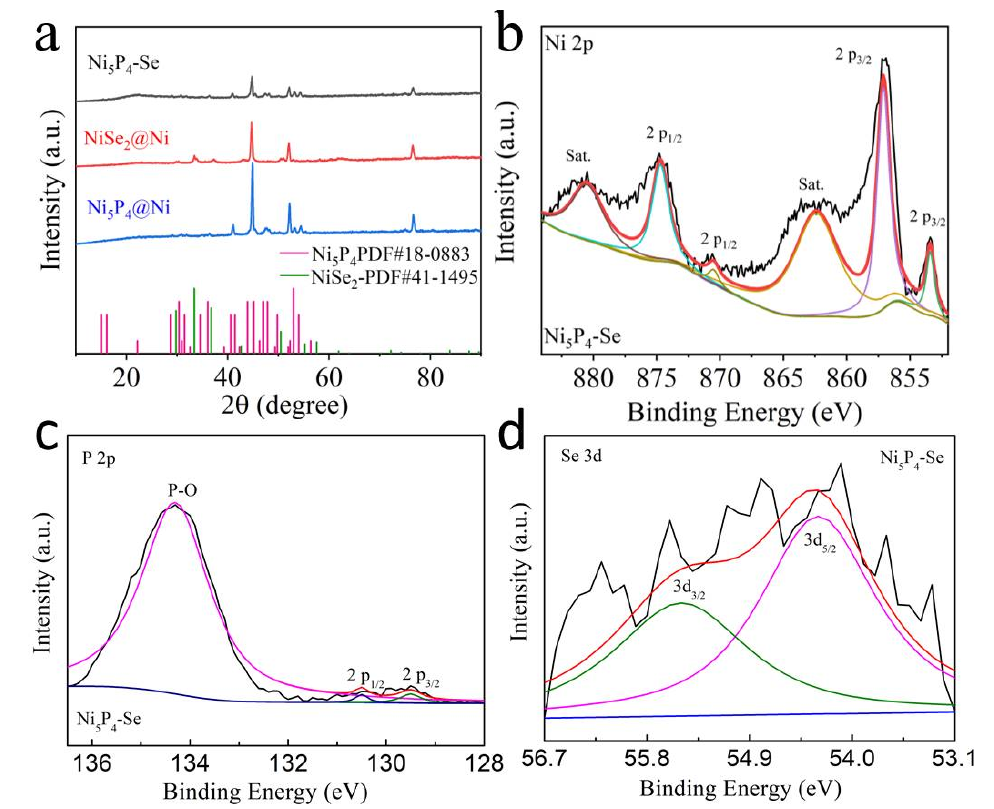
Figure 1. ( a ) XRD patterns of Ni 5 P 4 , NiSe 2 and Ni 5 P 4 -Se. XPS spectra of Ni 5 P 4 -Se: ( b ) Ni 2p, ( c ) P 2p, ( d ) Se 3d.